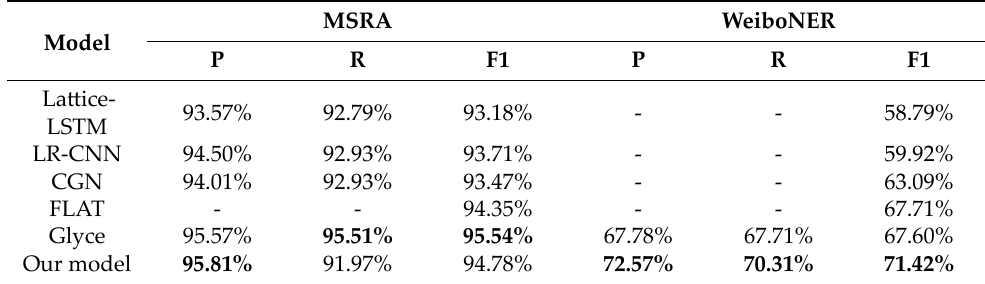
Table 2. Comparison of named entity recognition results of different